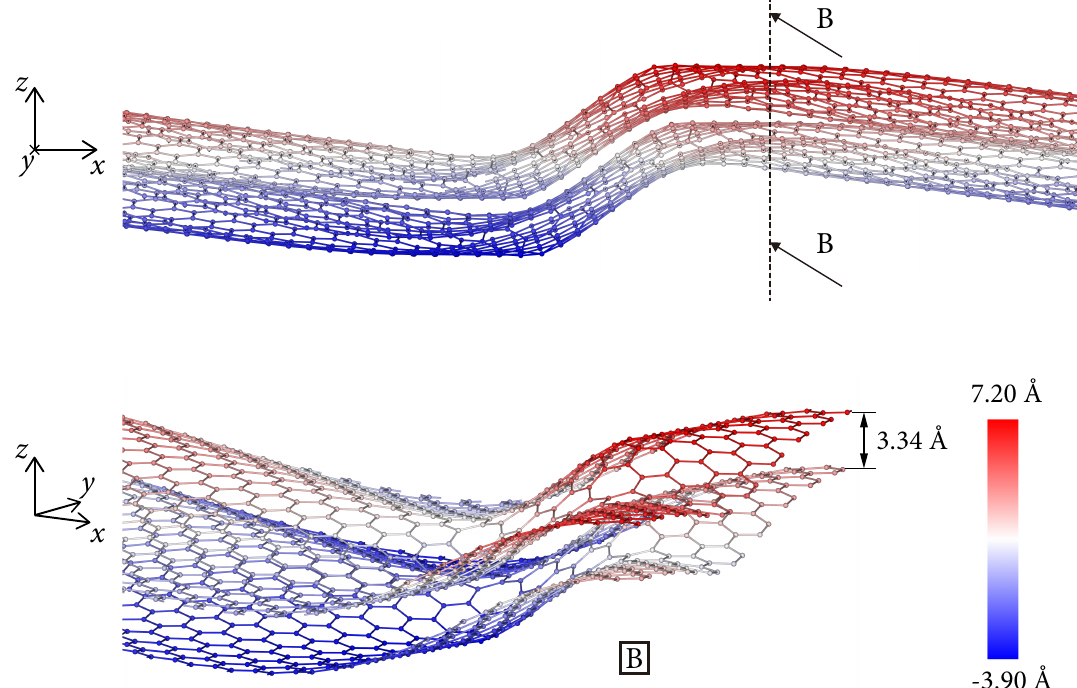
Figure 13. Front ( top ) and diagonal view B ( bottom ) of a bilayer arrangement with one n = 9 dipole in each layer, both at the same position in the xy plane. The color code indicates the out of plane position of